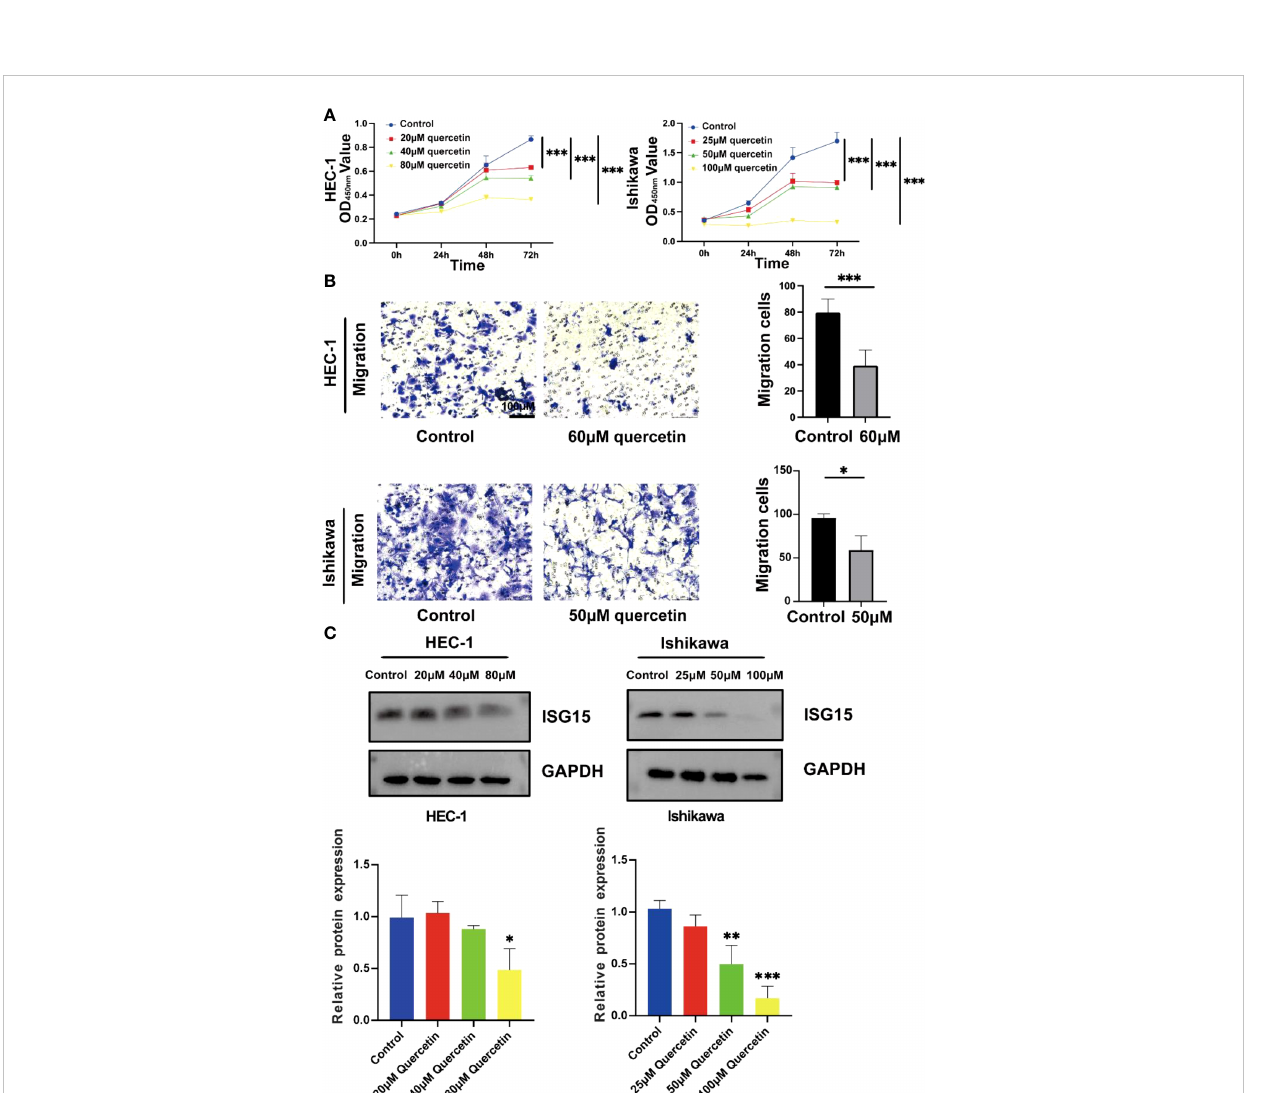
FIGURE 14 Quercetin inhibits the proliferation and migration of UCEC cells and reduces the expression of ISG15 . (A) Quercetin suppressed viability of HEC-1 and Ishikawa cells by CCK-8 assay. (B) Left panel: Transwell assays were used in HEC-1 and Ishikawa cells with or without quercetin. Right panel: Quantitative analyses for Transwell assays. (C) Western blotting showed quercetin reduced the expression of ISG15 . The bar graph showed the ratio of ISG15 level between quercetin treatment group and control group. * means P < 0.05; ** means P < 0.01; *** means P <